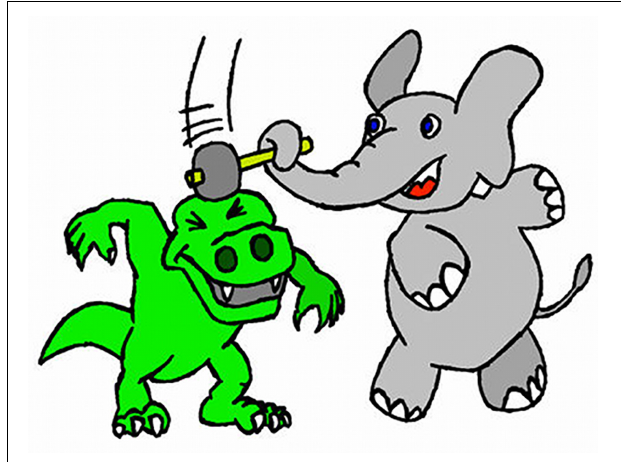
FIGURE 1 | Example of picture showing an other-oriented action.